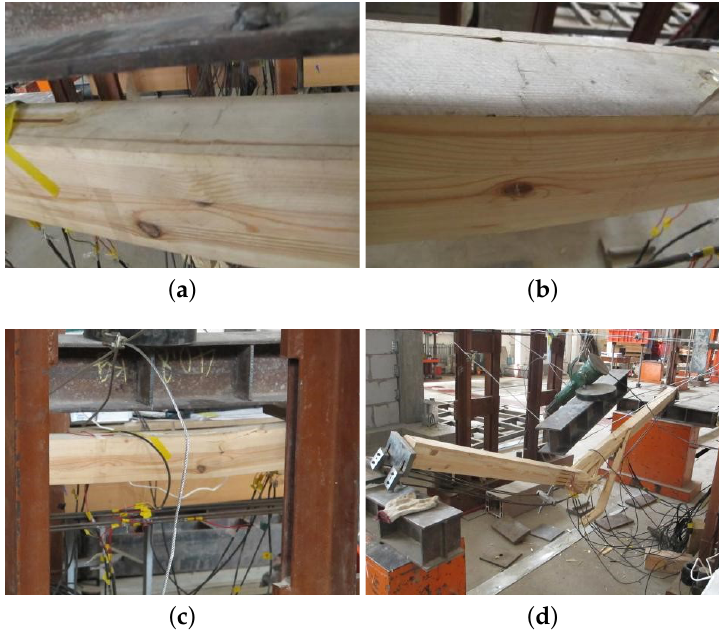
Figure 15. B2 failure mode. ( a ) Top fold, ( b ) fold extends along the section, ( c ) fold extended to the bottom and ( d ) destroyed suddenly.